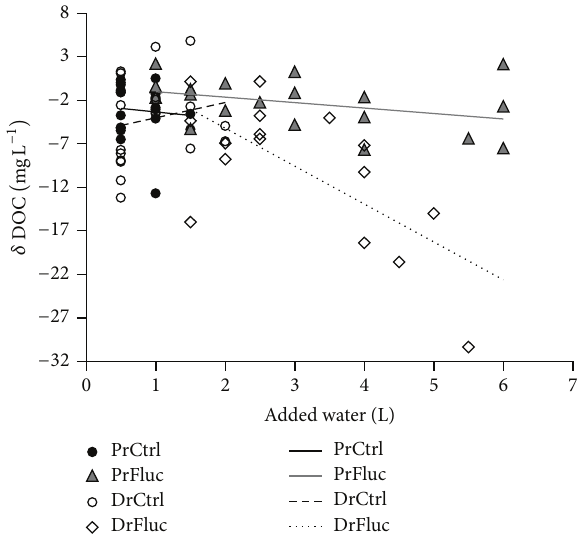
Figure 4: 𝛿 DOC in relation to the volume of added water in different experimental groups during phases WL(37)–WH(40), WH(40)–WH(42), WH(42)-WH(43), and WH(43)-WH(44) and their linear fitted lines. For PrCtrl, PrFluc, and DrCtrl 𝑛 = 20 (so five per phase). For DrFluc 𝑛 = 16 (one sample at WL(37)). Pr: pristine; Dr: drained; Ctrl: control; Fluc: fluctuating water table.